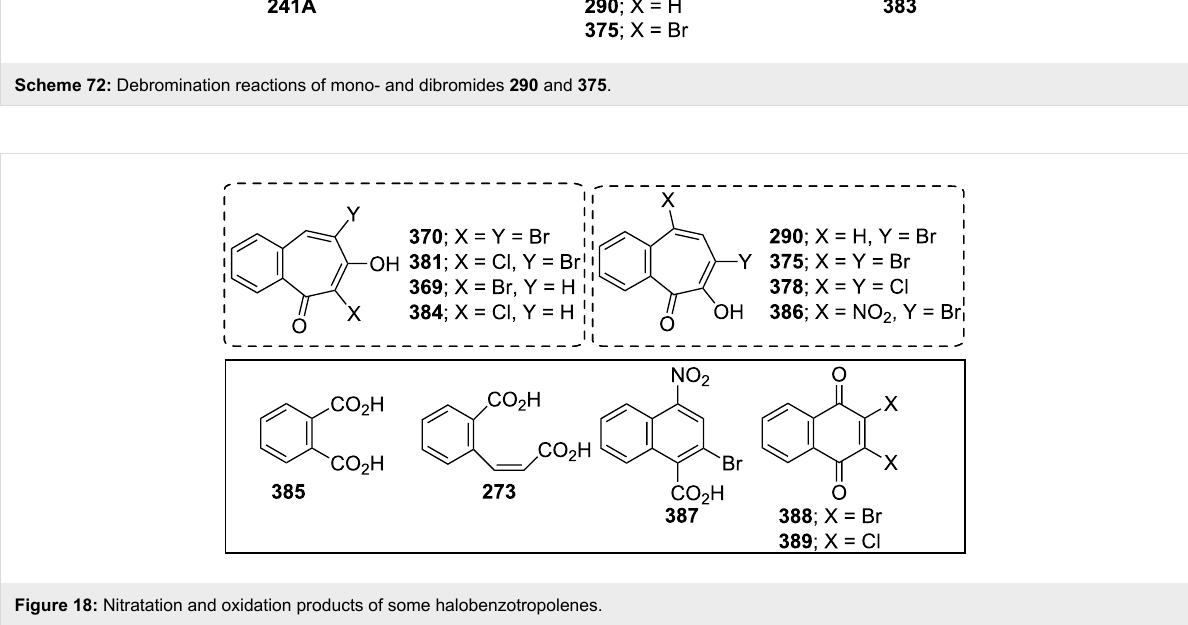
16% yields (Figure 18) [199].